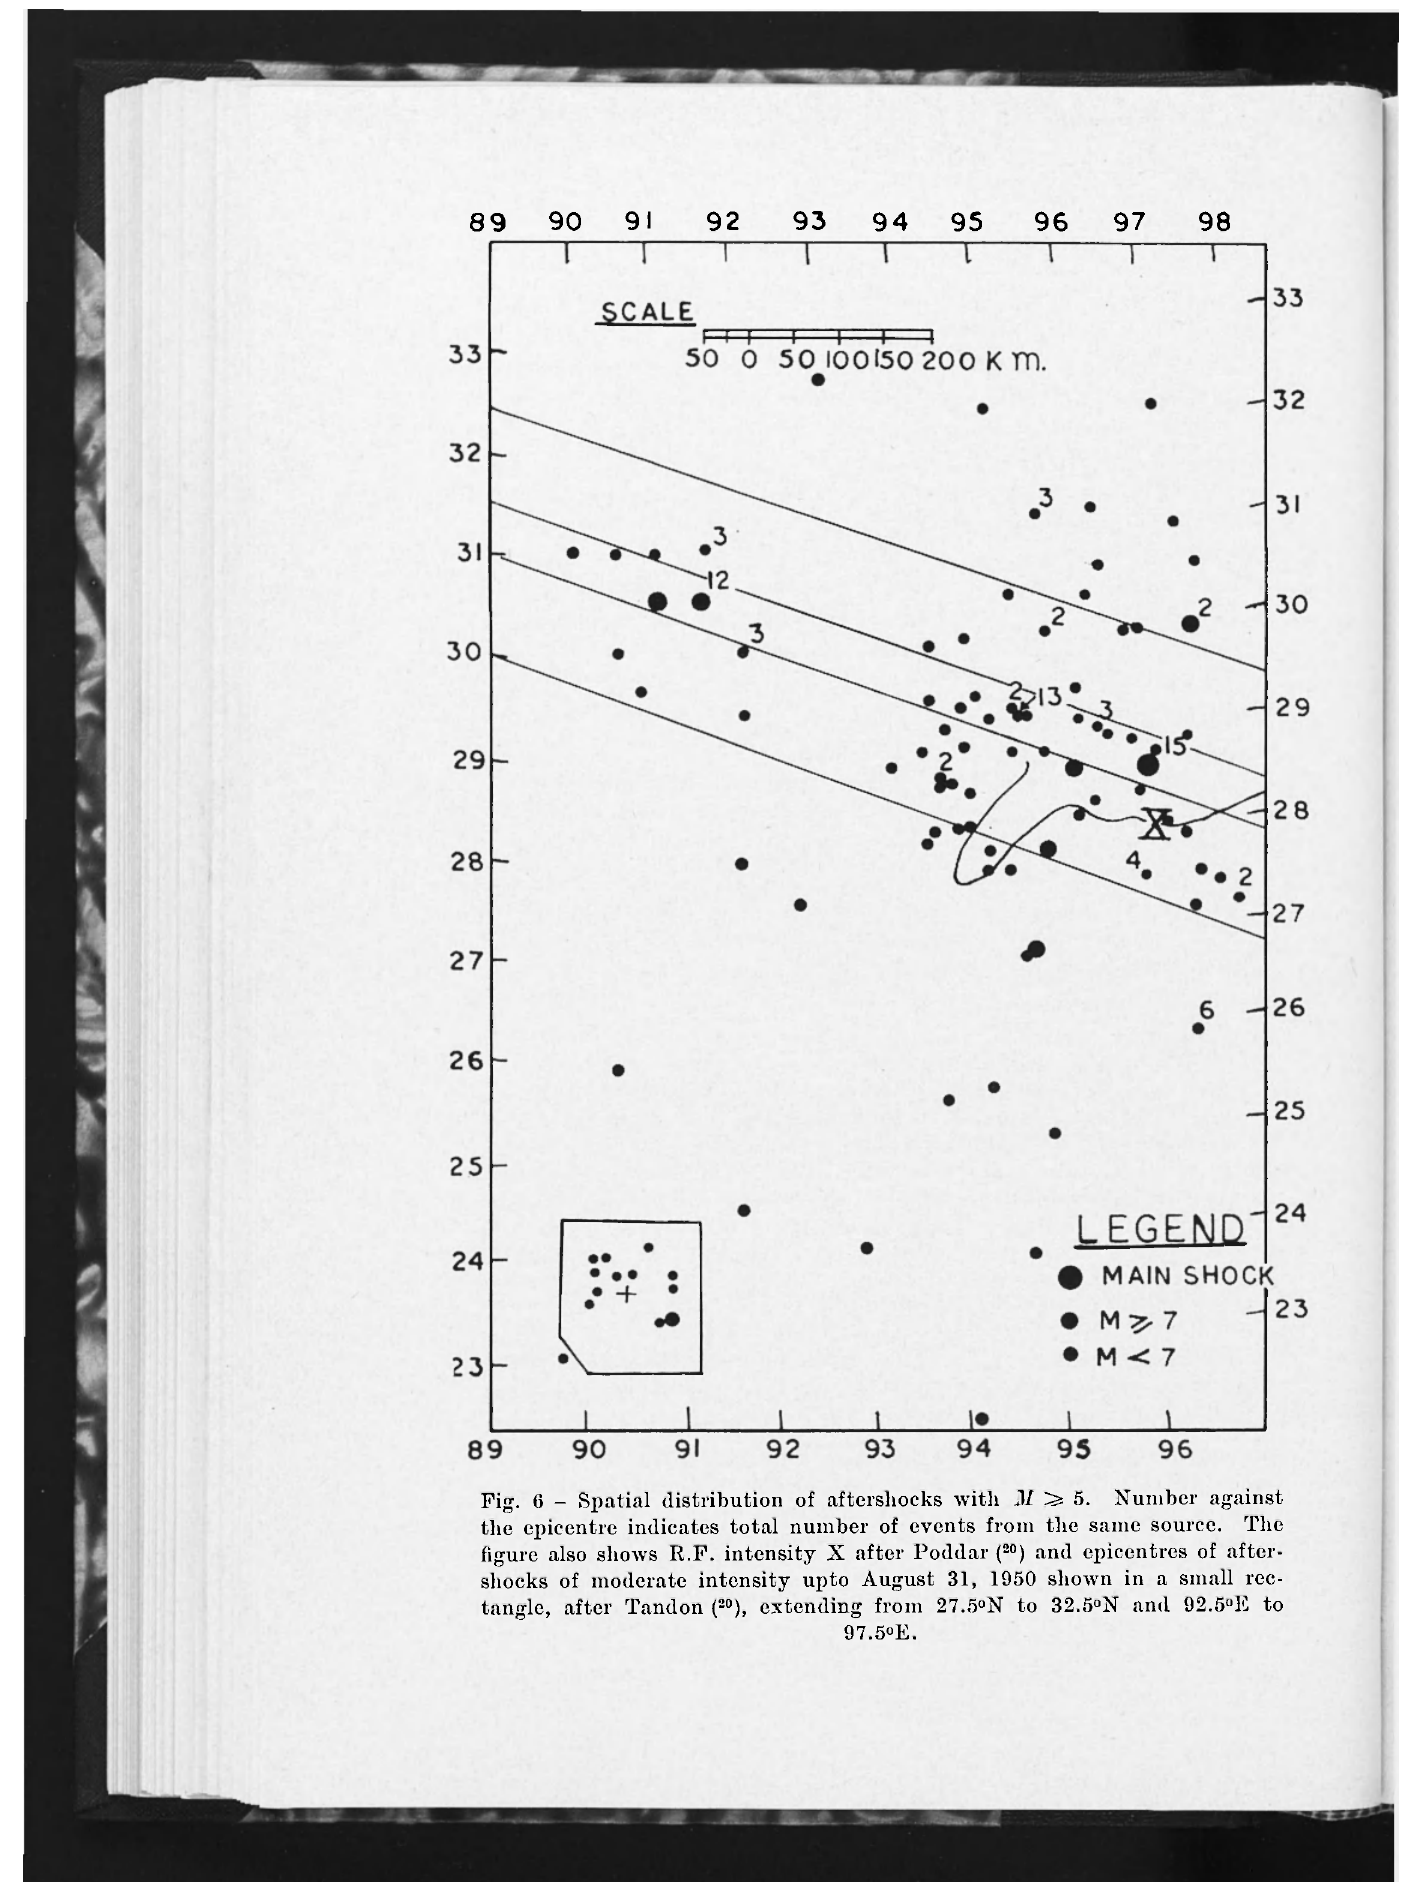
Fig. 6 - Spatial distribution of aftershocks with M 5. Number against the epicentre indicates total number of events from the same source. The figure also shows R.F. intensity X after Poddar ( 20 ) and epicentres of after- shocks of moderate intensity upto August 31, 1950 shown in a small rec- tangle, after Tandon ( 20 ), extending from 27.5°N to 32.5°N and 92.5°E to